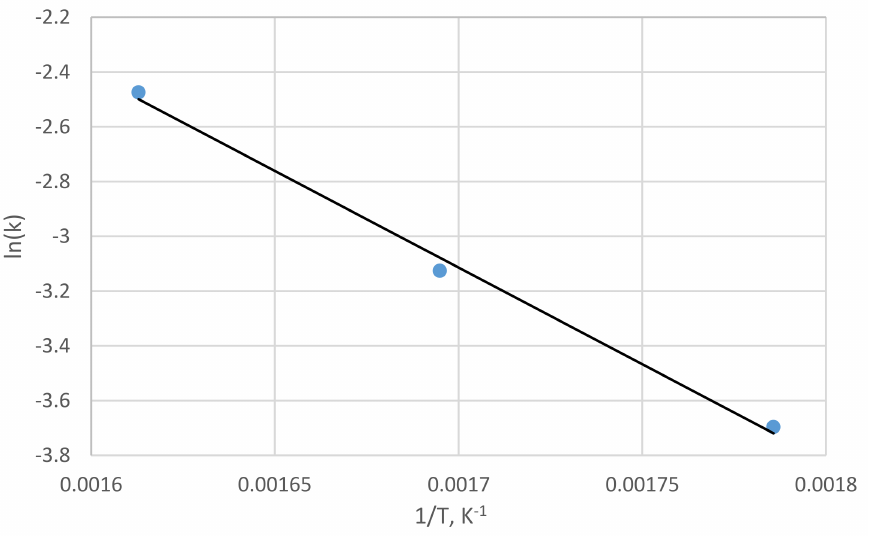
Figure 10. Arrhenius plot for supercritical transesterification reaction (molar ratio 1:39 and P = 351